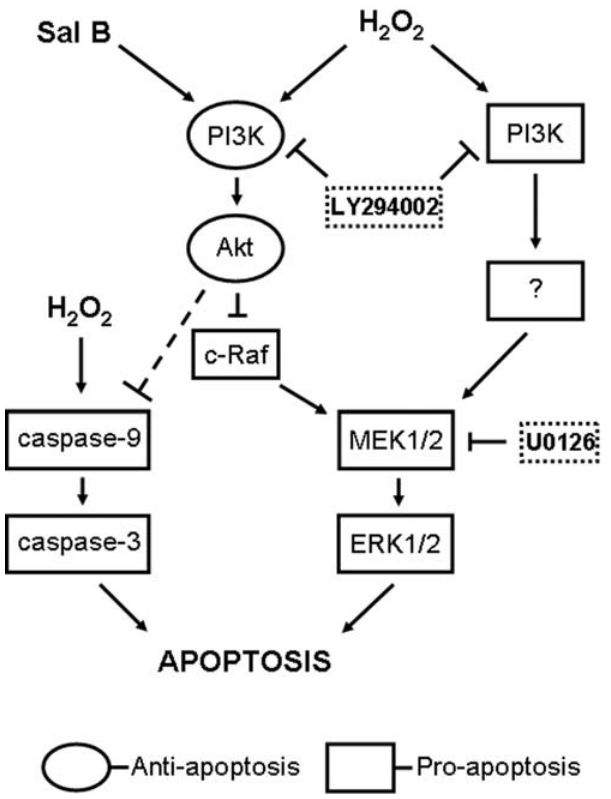
Figure 4. Schematic model of signaling events involved in H 2 O 2 - induced rCMECs apoptosis and Sal B preventive mechanism. The broken line indicates a possible link of Akt and caspase-9.